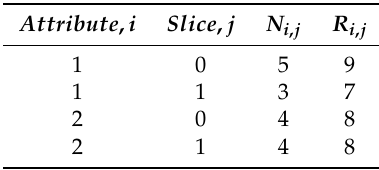
Table 4. Bit-slice length, N and maximum bit-length, R recommended by DataNode 2 .